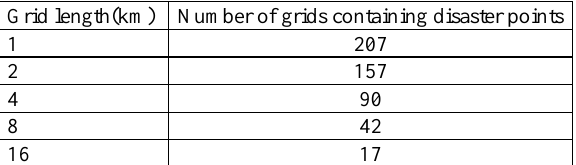
Table 1. The statistics of box dimension of spatial distribution of landslide in Dachuan District